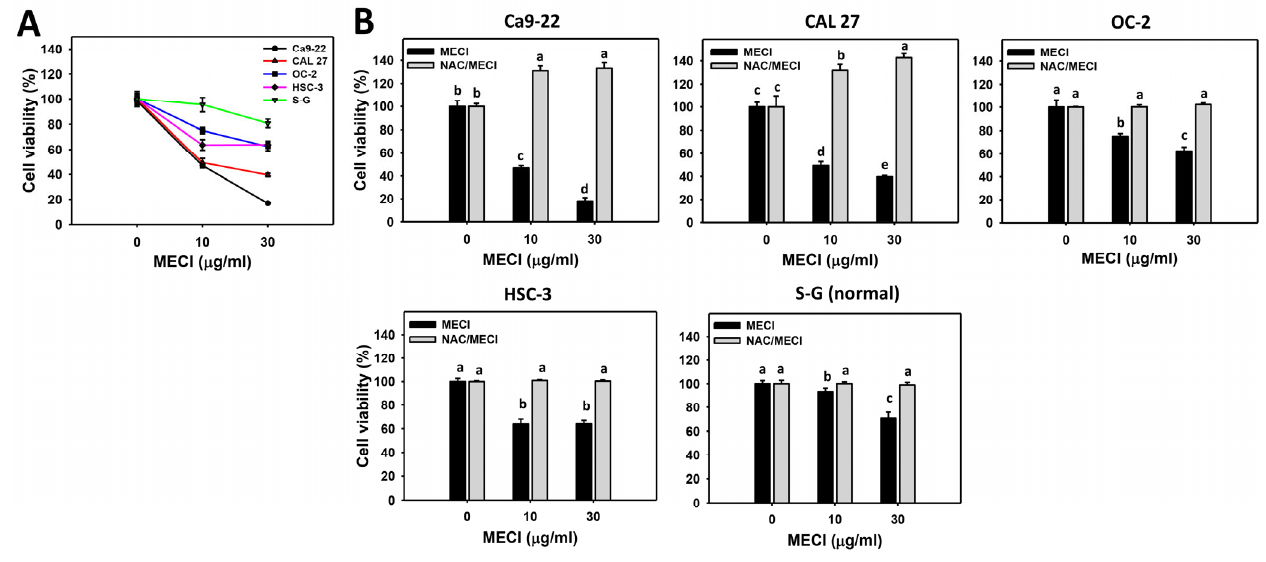
Figure 2. Antiproliferation. ( A ) Cell viabilities. Except for S-G cells, others were oral cancer cells. After 24 h MECI incubation, the cells were subjected to the MTS assay. ( B ) Impact of NAC on MECI- induced antiproliferation to oral cancer cells. After pretreating with NAC, cells were post-treated with MECI (0 (0.1% DMSO in the medium), 10, and 30 µ g/mL) for 24 h. With or without MECI, all drug treatments were adjusted to contain the same DMSO (0.1%) in the medium. Data, mean ± SD ( n = 3). For the same cell line, columns showing non-overlapping letters differ significantly ( p < 0.05).